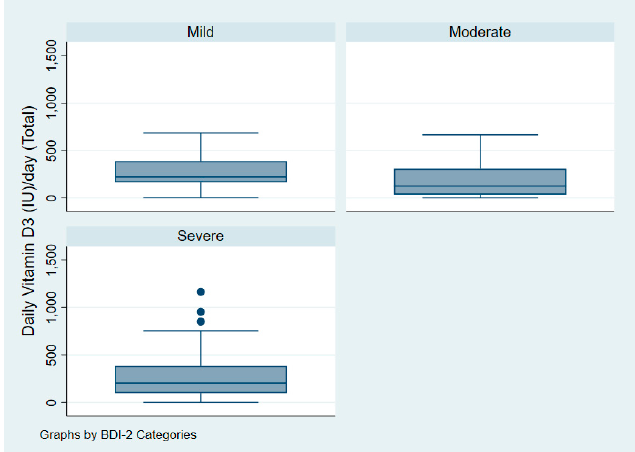
Figure 3. Vitamin D dose (IU/day) of patients with depression according to symptoms severity.